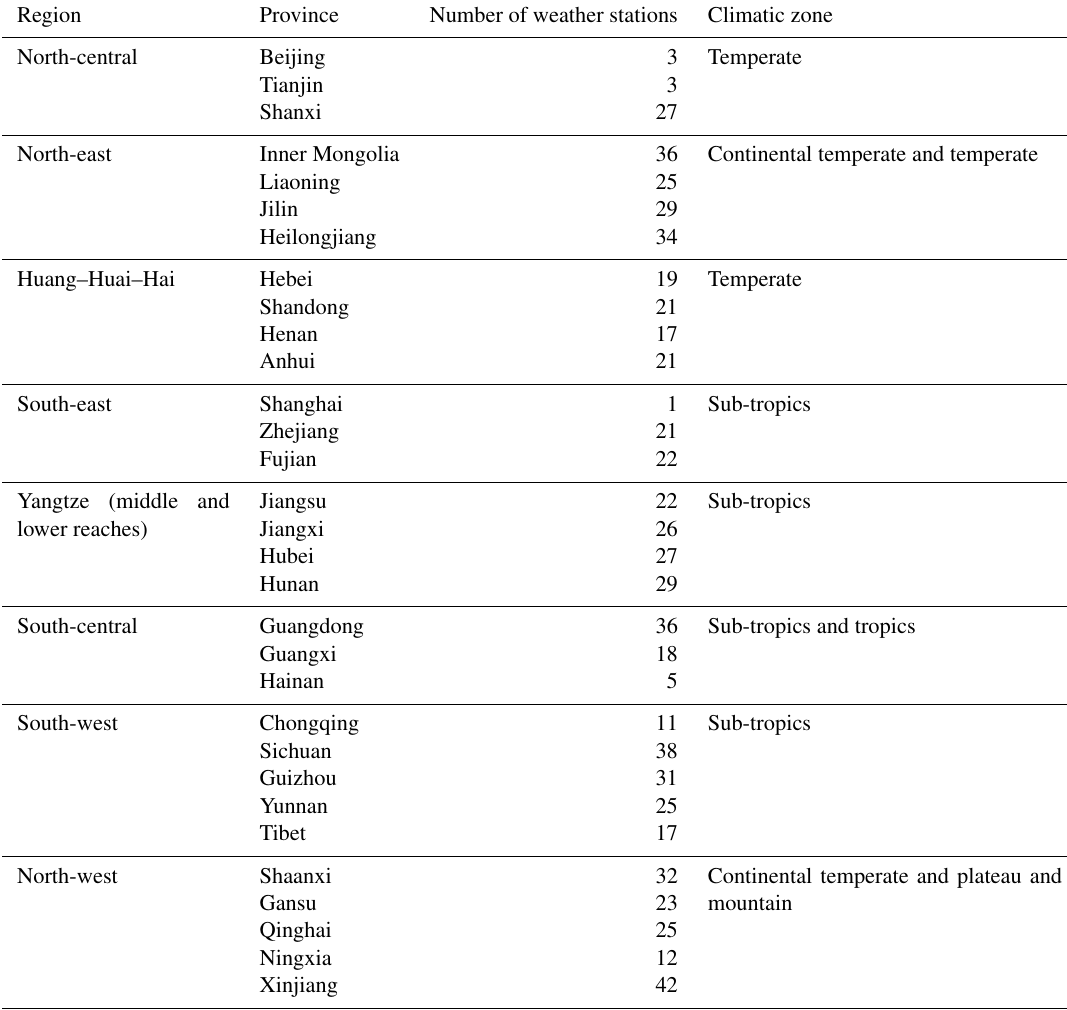
Table 1. Number of meteorological stations per province. Region